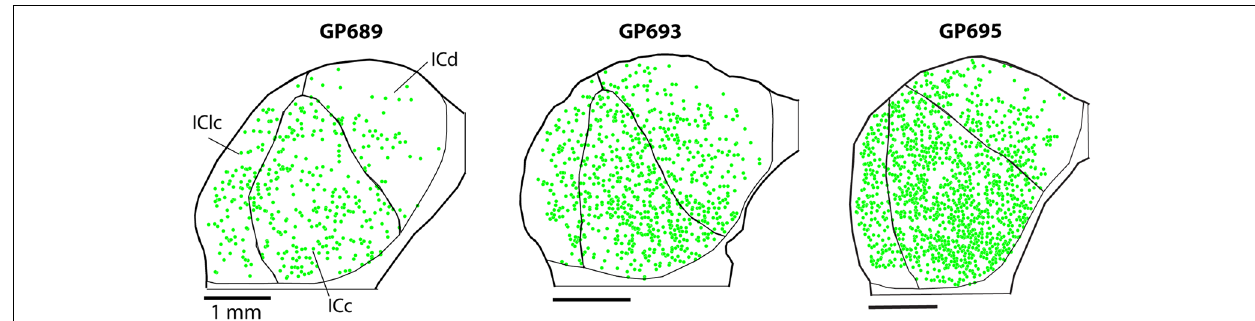
FIGURE 3 | Plots ofWFA-labeled PNs (green circles) showing the variation in PN density across three cases. In each case, the average PN density is highest in the ICc, but the absolute density of PNs varies, ranging